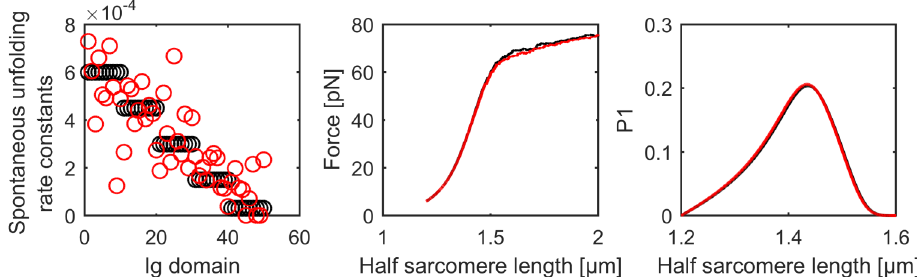
Fig 8. Comparison of different Ig clusters. The simulations are based on 50 Ig clusters (red) and 5 Ig clusters (black), respectively. The spontaneous unfolding rate constant (left panel) declines linearly but is perturbed by a Gaussian noise (SD = 0.2) in the case of 50 Ig clusters. The average force based on the Monte Carlo simulations of 50 titin strands (middle panel) as well as the probabilities of unfolding events as a function of half sarcomere length (right panel) are comparable between 50 Ig clusters (red) and 5 Ig clusters